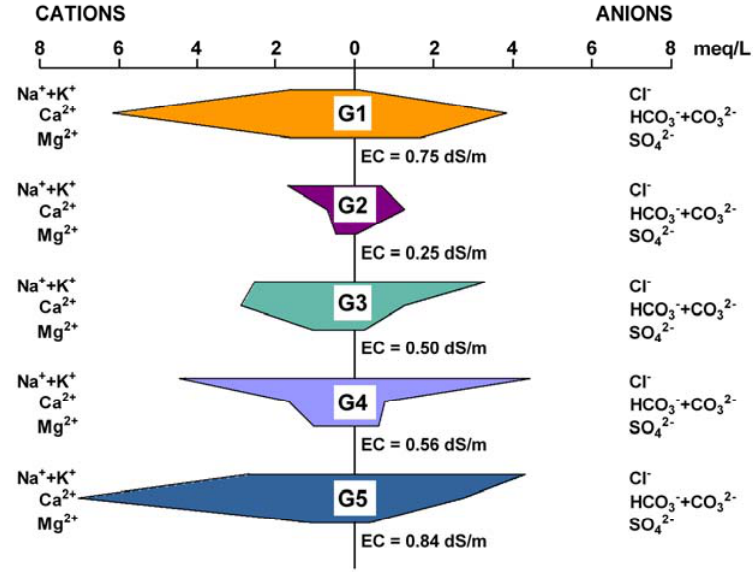
Figure 4. Stiff diagram of the groundwater of sampling wells (G1, road control; G2, residential control; and G3 to G5, study wells). For each ion, data are expressed as mean values (meq/L) of the monitoring performed from summer to autumn 2013. EC: electrical conductivity.